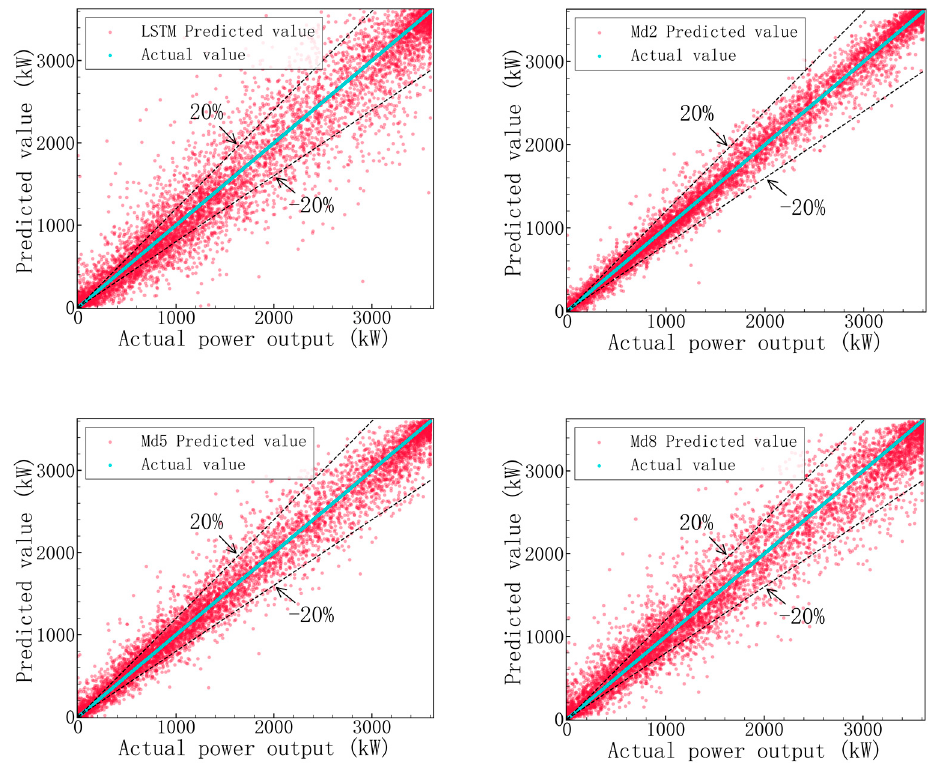
Figure 16. Diagram of the scattering of predicted values.